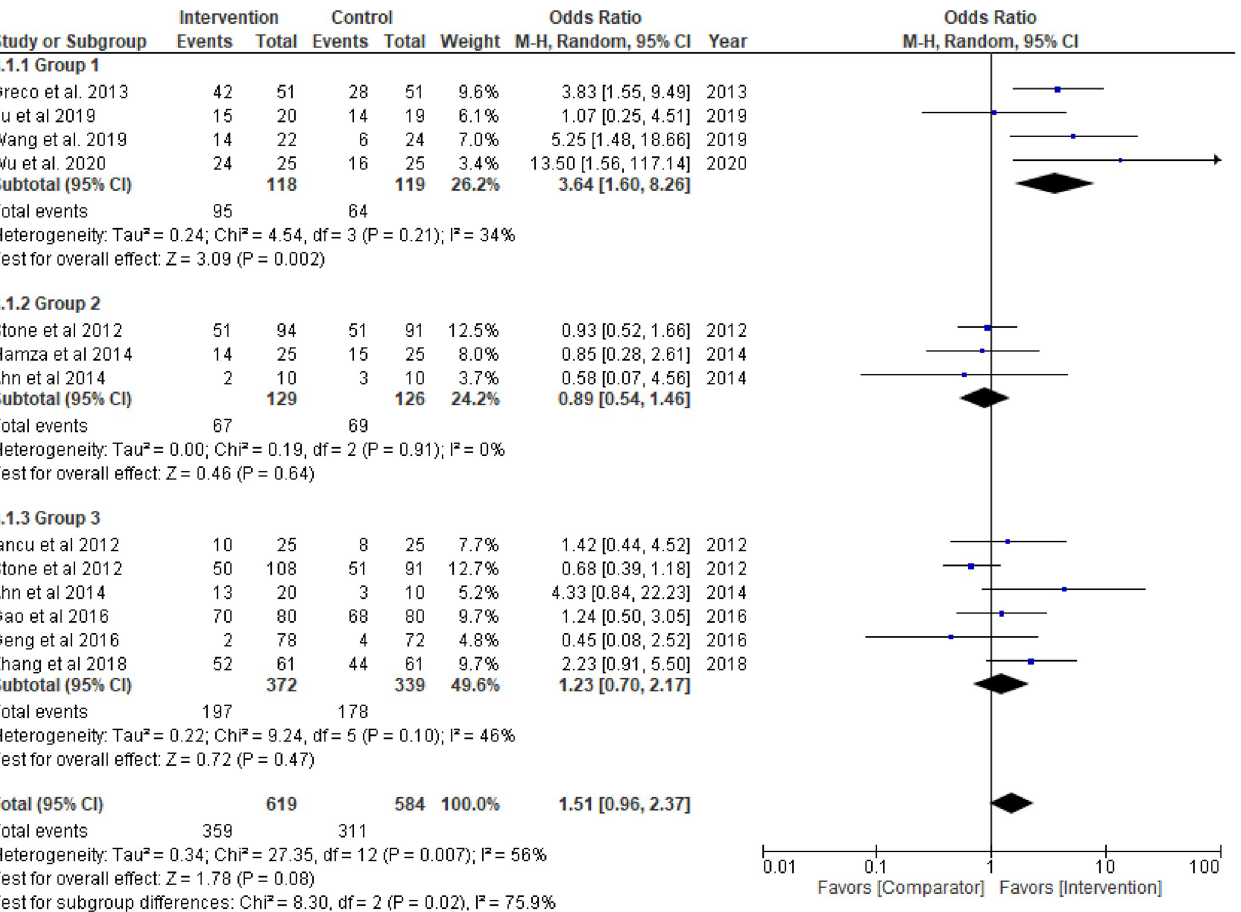
Fig 4. ST-segment resolution. Group 1: Thrombolytic agent; Group 2: Glycoprotein IIb/IIIa inhibitors (GPI); Group 3: GPI plus aspiration thrombectomy.